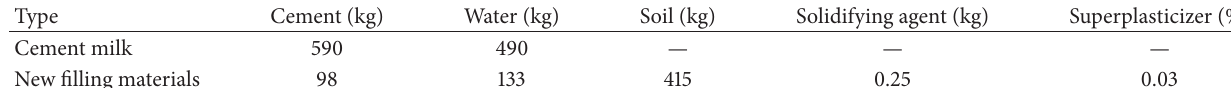
Table 7: The actual amount of injected filling materials [for a pile 9.0 m].